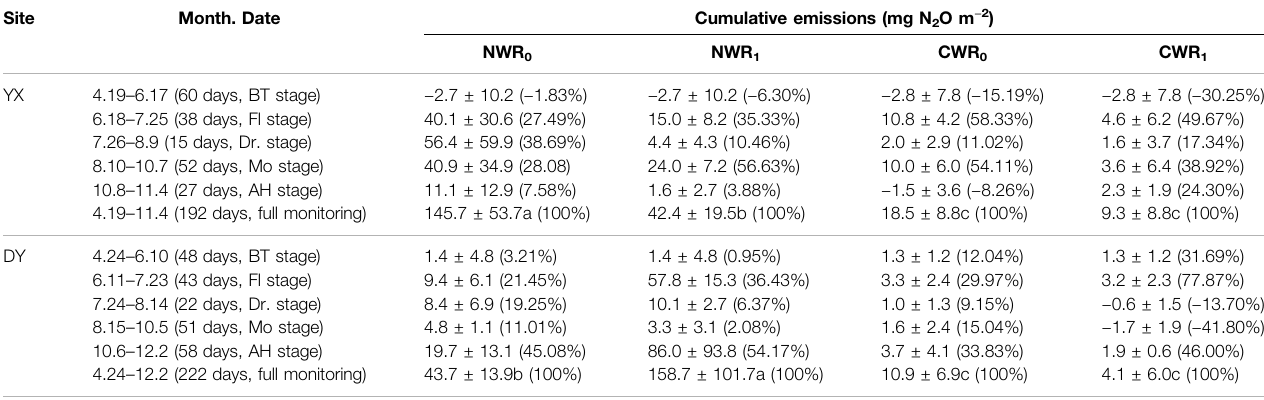
TABLE 2 | N 2 O cumulative emissions and ratio at different stages during the monitoring